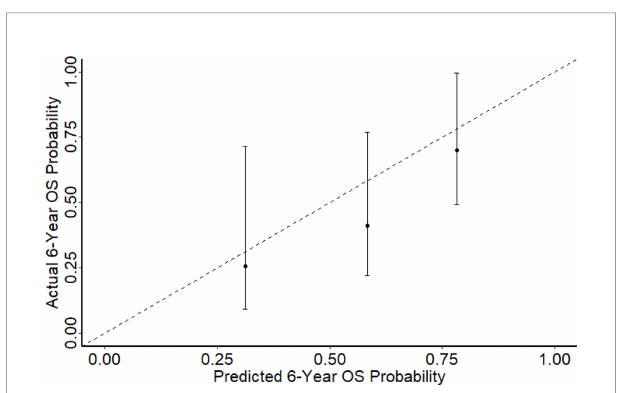
FIGURE 2 | Calibration plot showing 6-year OS against predicted